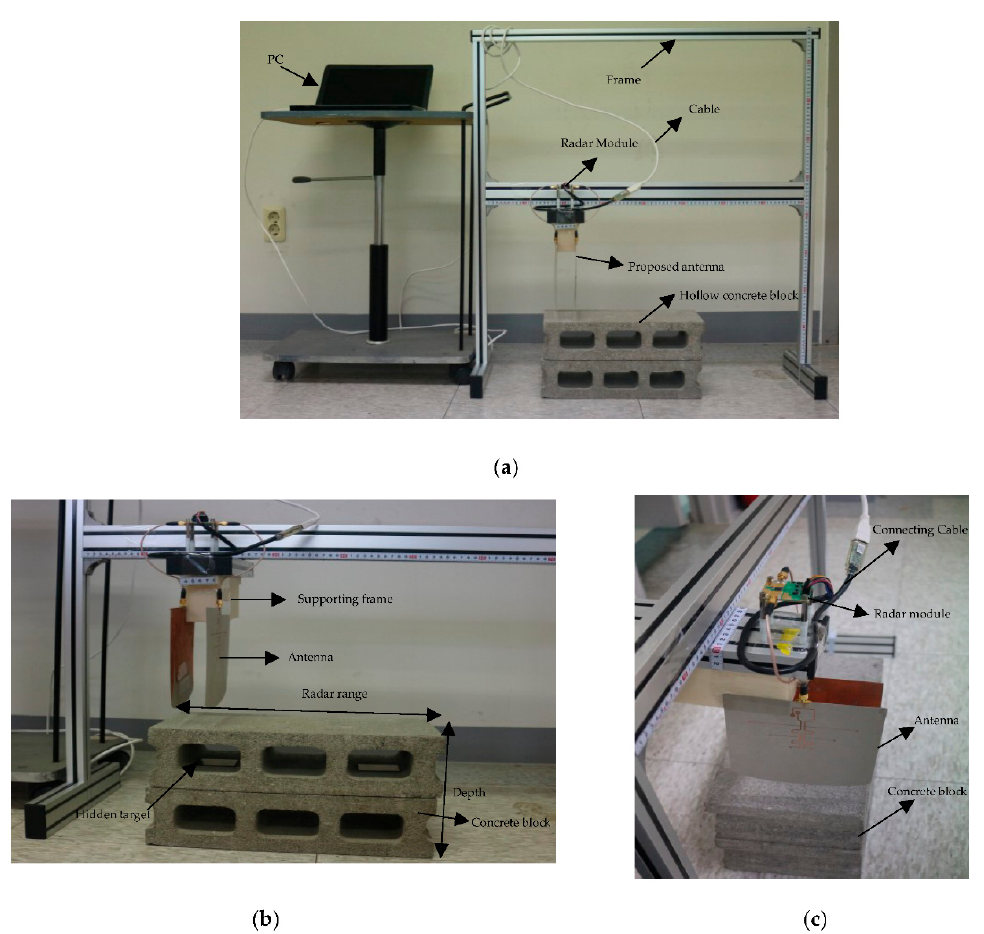
Figure 8. Experimental measurement setup: ( a ) setup arrangement with antenna scanning the concrete beam with the target within; ( b ) proposed antenna with radar module support and concrete brick and; ( c ) UWB radar module.